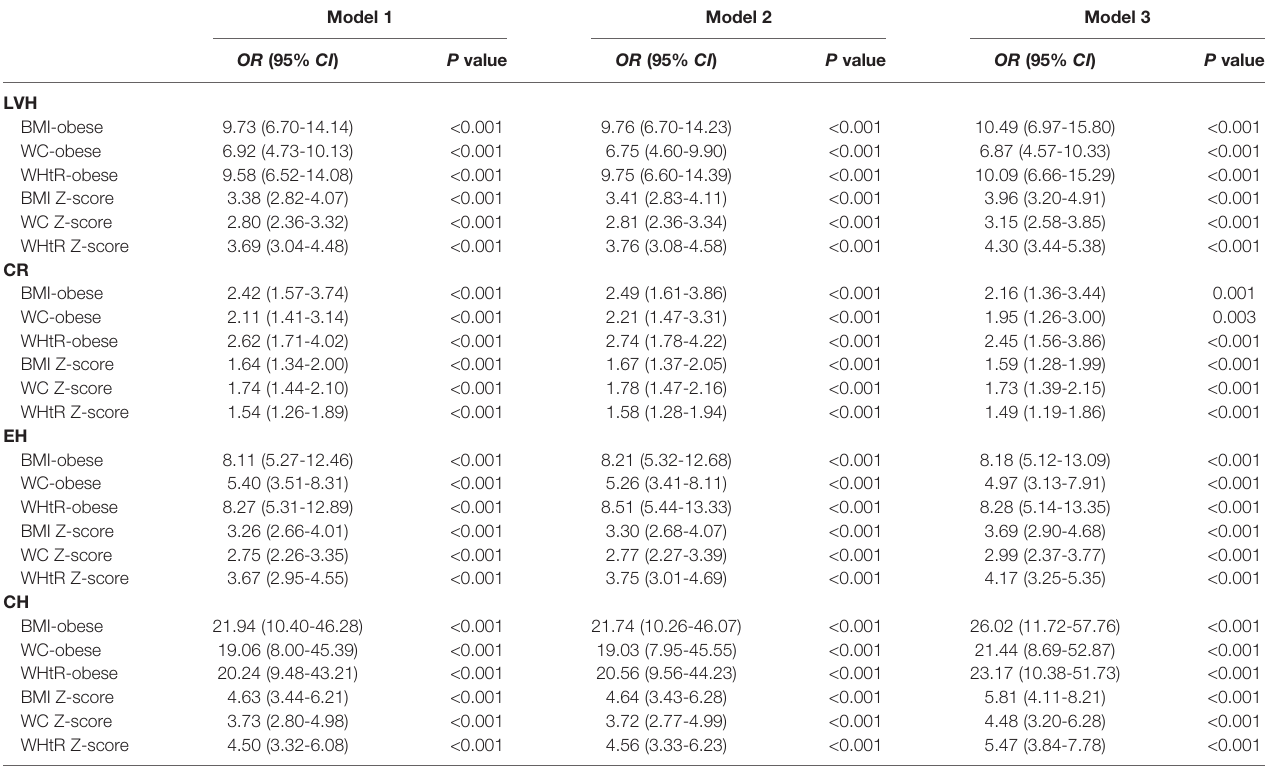
OR, odds ratio; CI, con fi dence interval; LVH, left ventricular hypertrophy; CR, concentric remodeling; EH, eccentric hypertrophy; CH, concentric hypertrophy; BMI, body mass index; WC, waist circumference; WHtR, waist-to-height ratio. Model 1: Adjusted for sex and age. Model 2: Model 1 + daily sleep duration, daily screen time, daily physical activity, frequency of daily vegetable/fruit intake and frequency of weekly soft drink intake. Model 3: Model 2 + Z-scores for systolic and diastolic blood